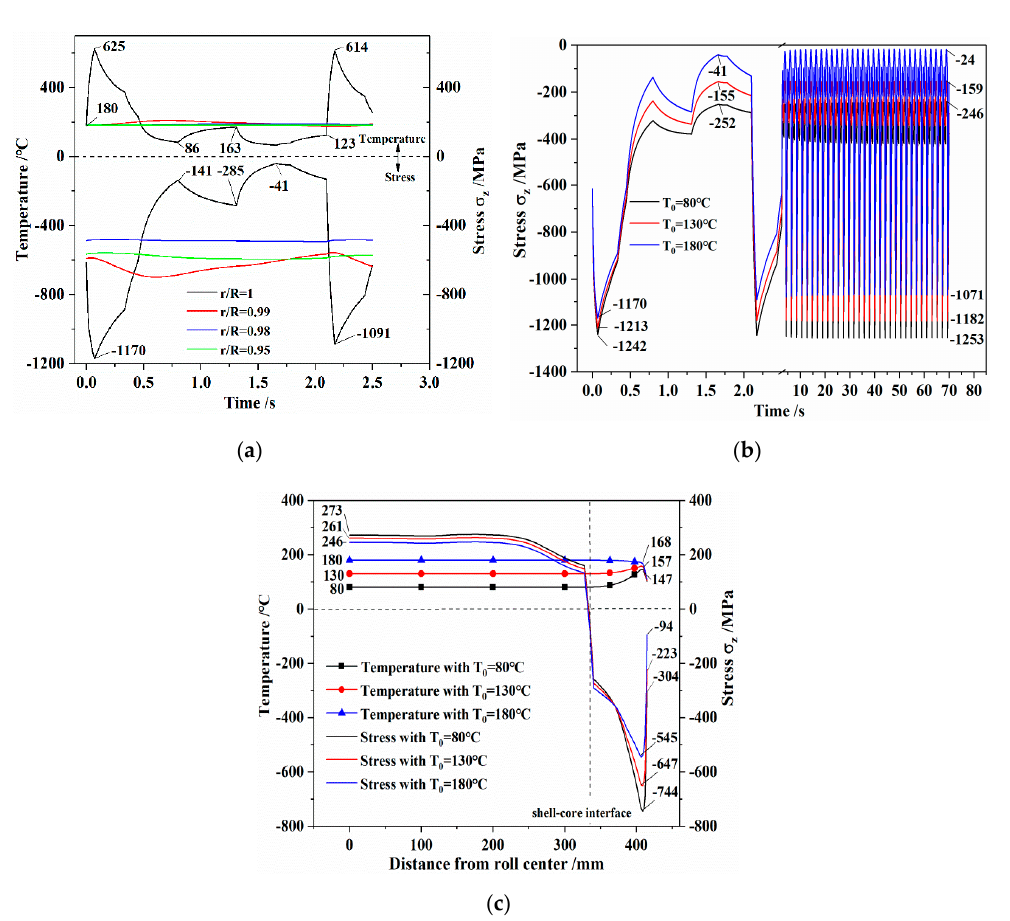
Figure 8. Temperature and thermal stress considering the initial residual stress under the different initial roll temperatures during hot rolling: ( a ) temperature and stress with an initial roll temperature of 180 °C during the first revolution; ( b ) comparison of stresses with different initial roll temperatures; ( c ) distributions of stress and temperature after one strip rolling.